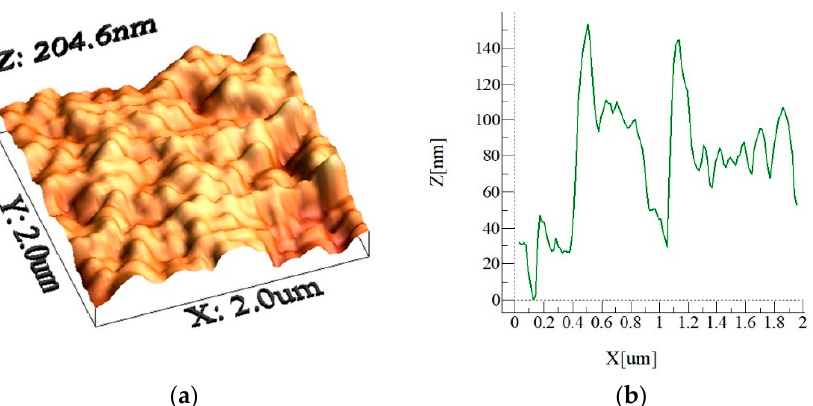
Figure 2. Three ‐ dimensional AFM image of the etched silicon ‐ wafer surface and line scan: ( a ) image of the etched surface and ( b ) line scan of the etched surface.